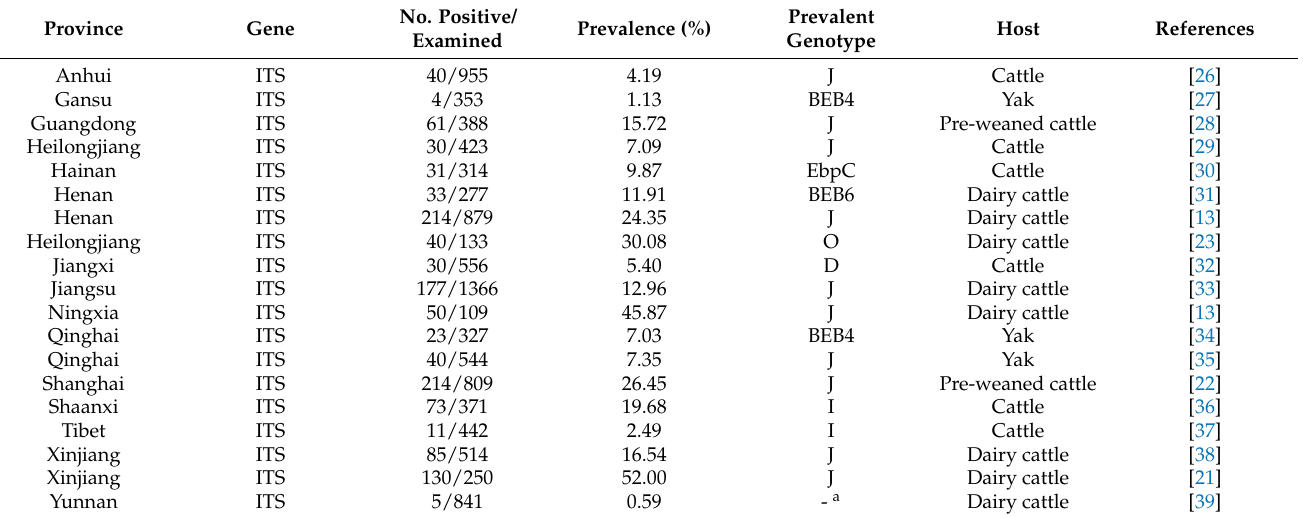
Table 3. Prevalence and prevalent genotype of Enterocytozoon bieneusi in cattle in